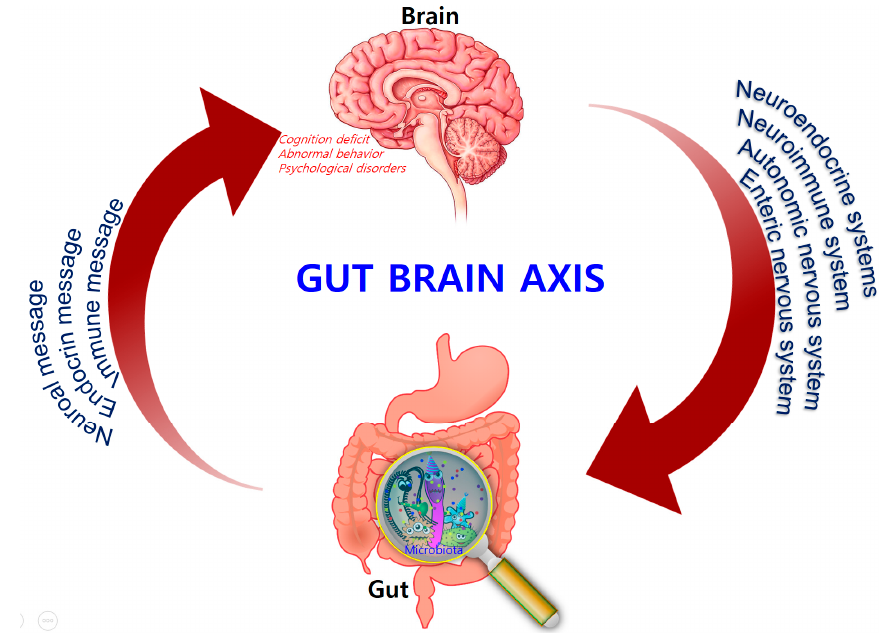
Figure 1. Bidirectional signaling between the gastrointestinal tract and the brain is regulated at the neural, hormonal, and immunological